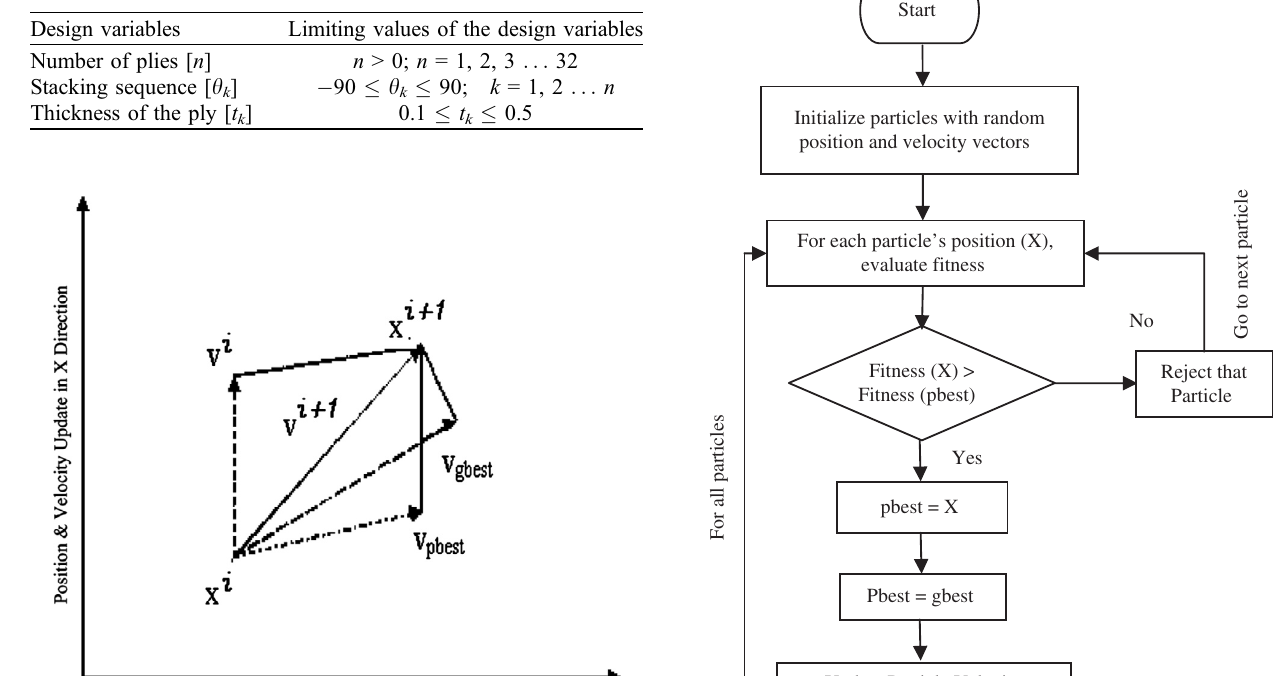
Table 1. Design variables with their limiting values.